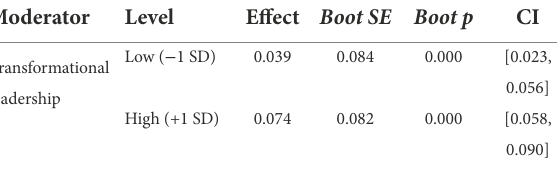
TABLE 4 Conditional indirect